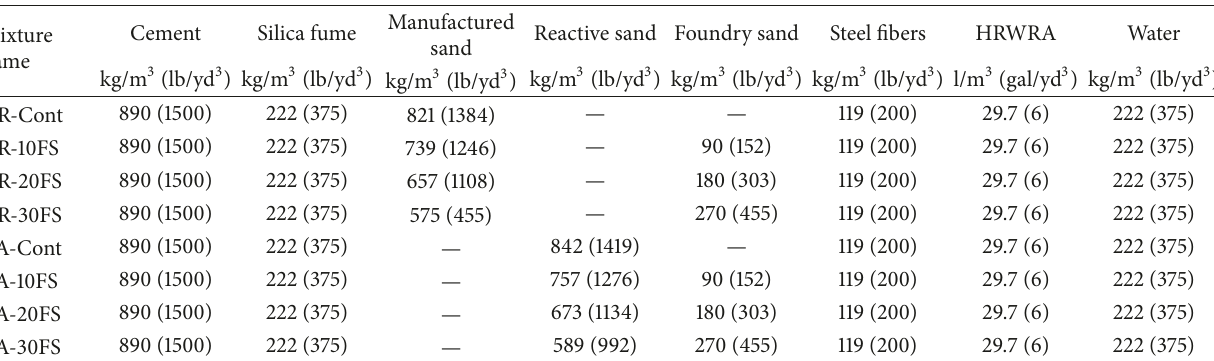
Table 5: Concrete mixture